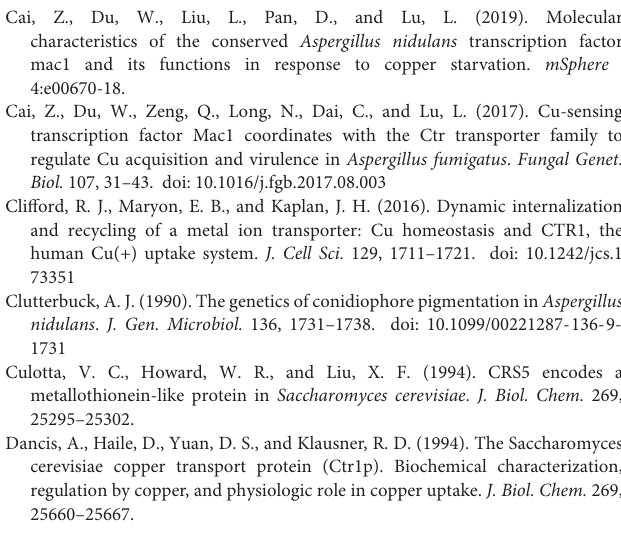
Supplementary Figure 1 | Southern-blot validation of the mutant strains generated in this study. AnHhoA:mRFP strains were validated by